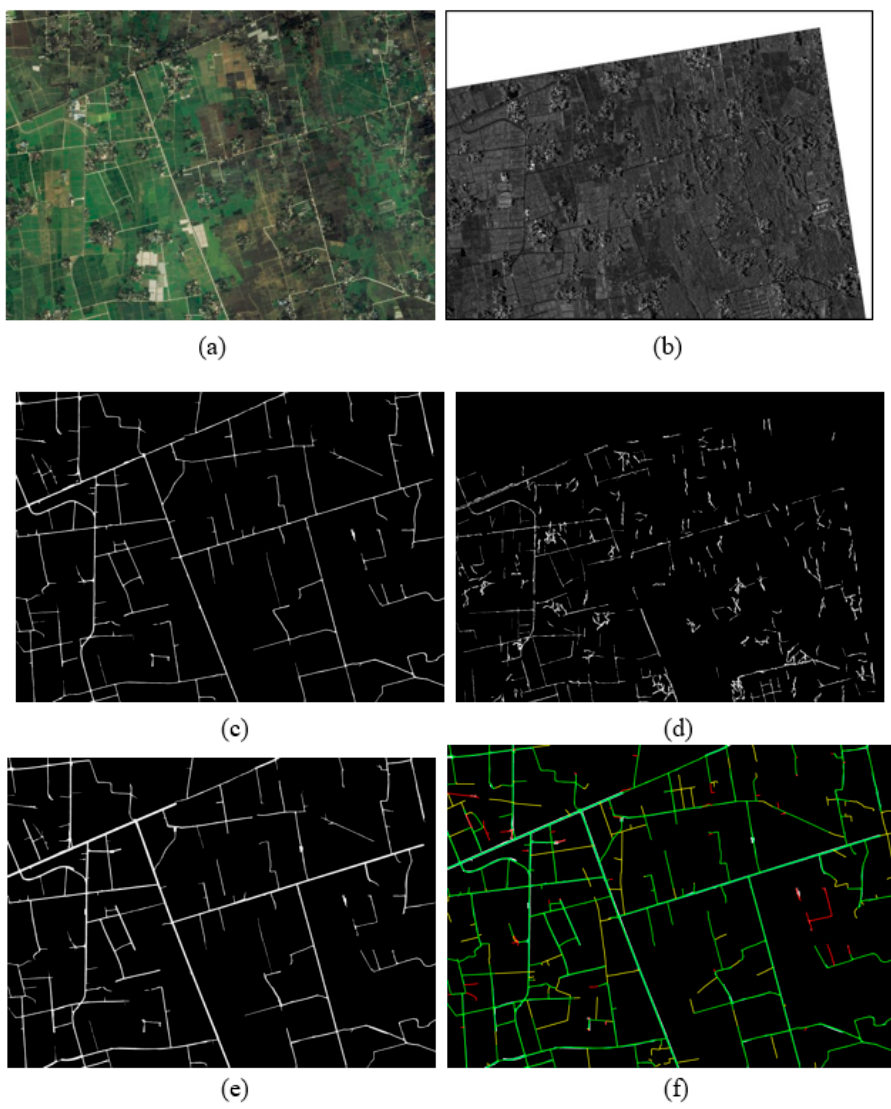
Figure 22. Tested data Area 1. Optical and SAR remote sensing images and road extraction results in the Chongzhou area. ( a ) Worldview-4 optical remote sensing image; ( b ) TerraSAR-X remote sensing image; ( c ) road extraction results of optical remote sensing image; ( d ) road extraction results from SAR remote sensing images; ( e ) road fusion extraction results of optical and SAR images; ( f ) ground truth and marking results of road fusion extraction results (green refers to the correctly extracted road, red refers to the incorrectly extracted road, and yellow refers to the omitted real road).